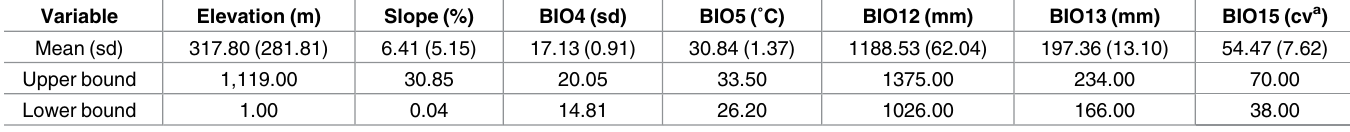
Table 3. Mean and standard deviation of the most relevant environmental variables of the occurrenceof cutaneous leishmaniasis in the state of Espı´rito Santo, Brazil,